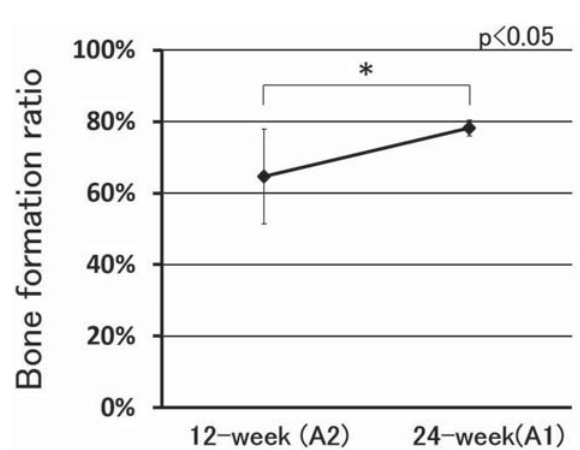
Figure 6- Ratio of newly bone formed of sample A.